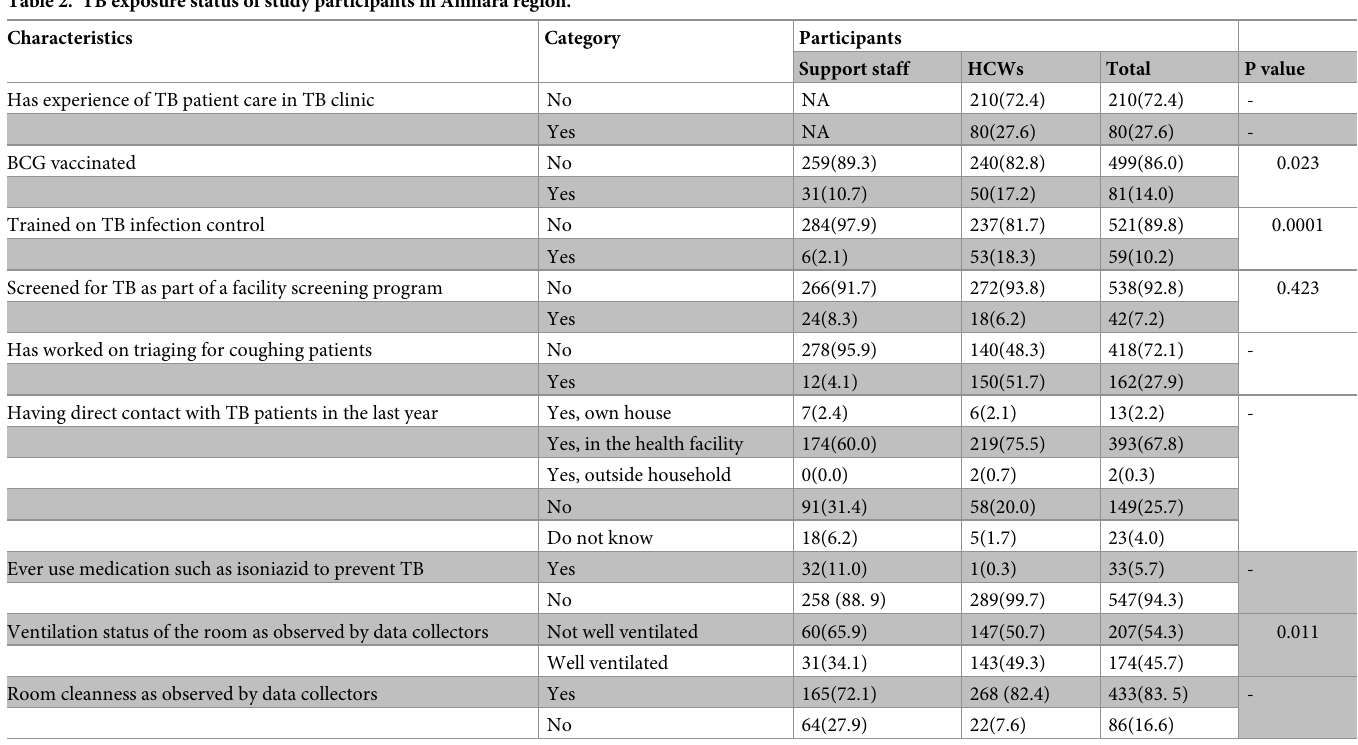
Table 2. TB exposure status of study participants in Amhara